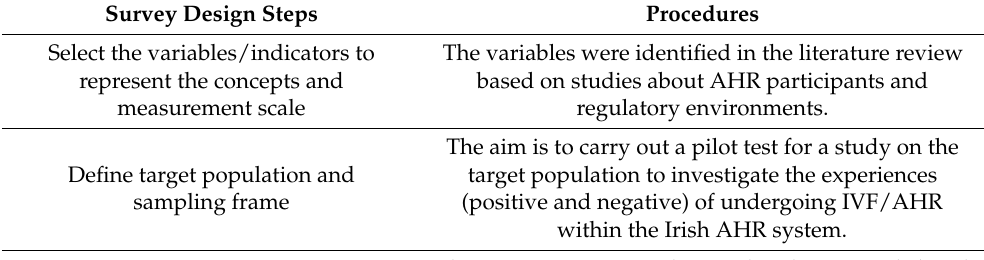
Table 1. Questionnaire design